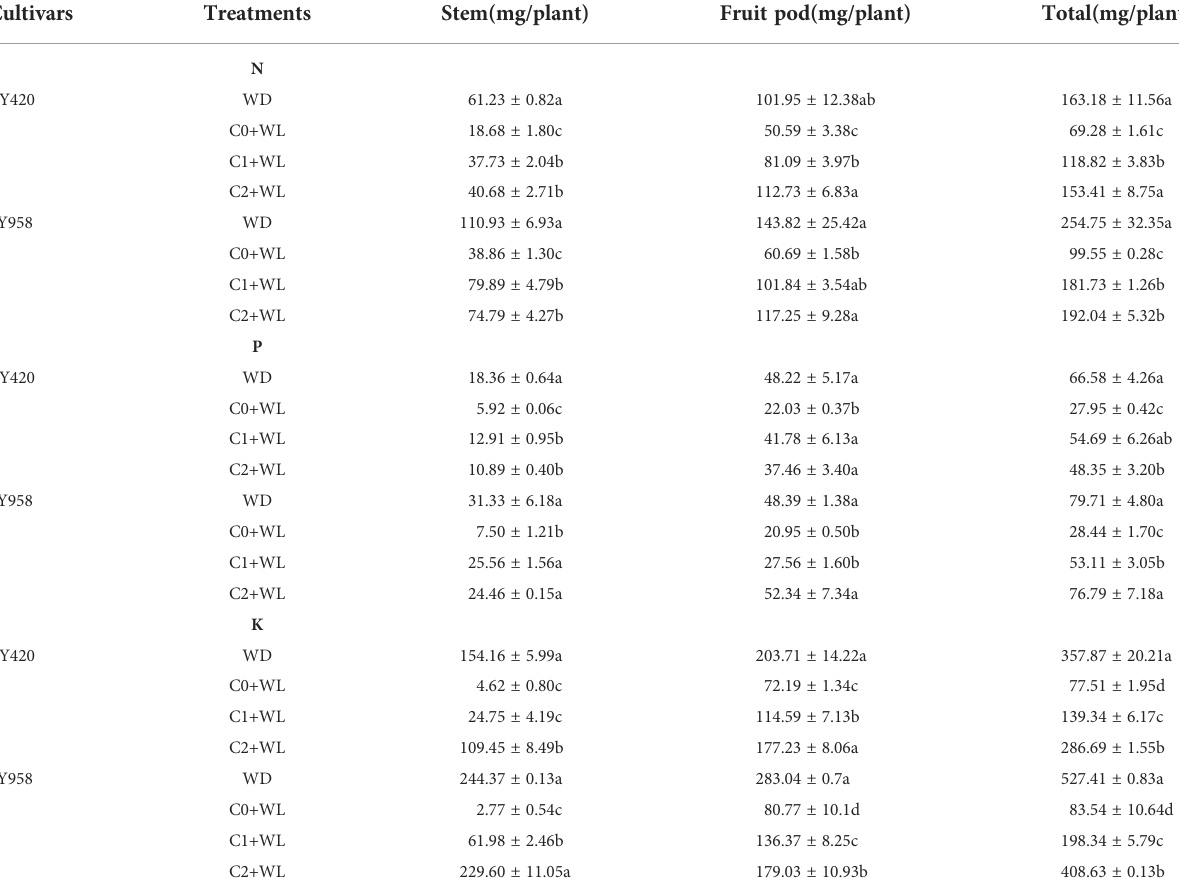
TABLE 3 Effect of calcium peroxide on the accumulation of nutrients and distribution under waterlogging conditions.